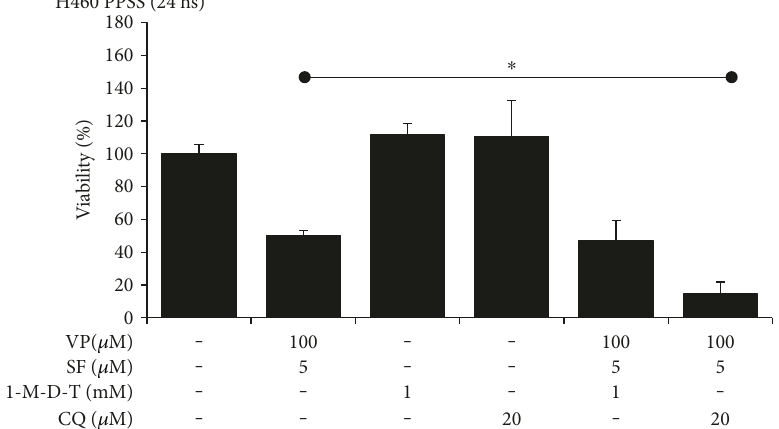
Figure 6: Chloroquine potentiates VP +SF e ff ects on cell viability. Cells growing under PPSS for 8 – 10 days were incubated with VP (100 μ M) +SF (5 μ M) alone or in the presence of 1-M-D-T or CQ for 24h. Cell viability was measured by the MTT assay. Results ( X ± SD) are representative of two independent experiments performed in sextuplicate. ∗ indicates P < 0 01